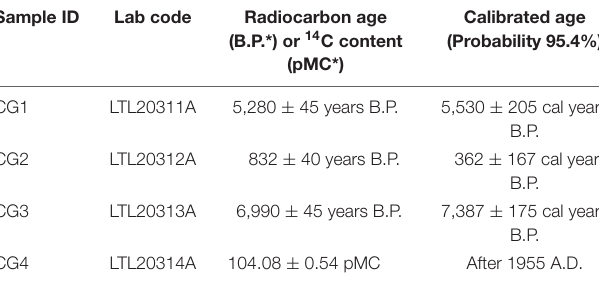
TABLE 1 | Radiocarbon measurements performed on the lapilli tuff-encrusting coralligenous (Actea